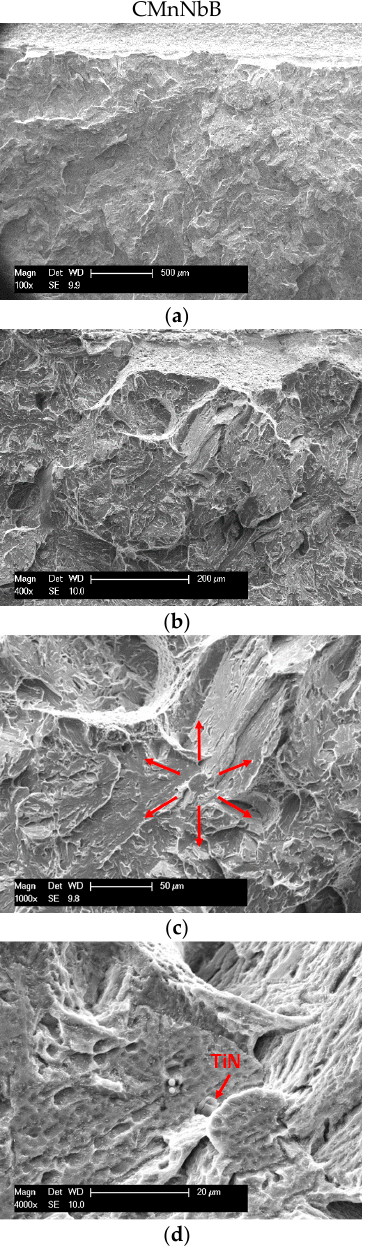
Figure 3. Fracture surfaces at different magnifications showing the crack-initiation site: ( a – d ) CMnNbB (test temperature of − 100 °C) and ( e – h ) CMnMoB (test temperature of − 120 °C).